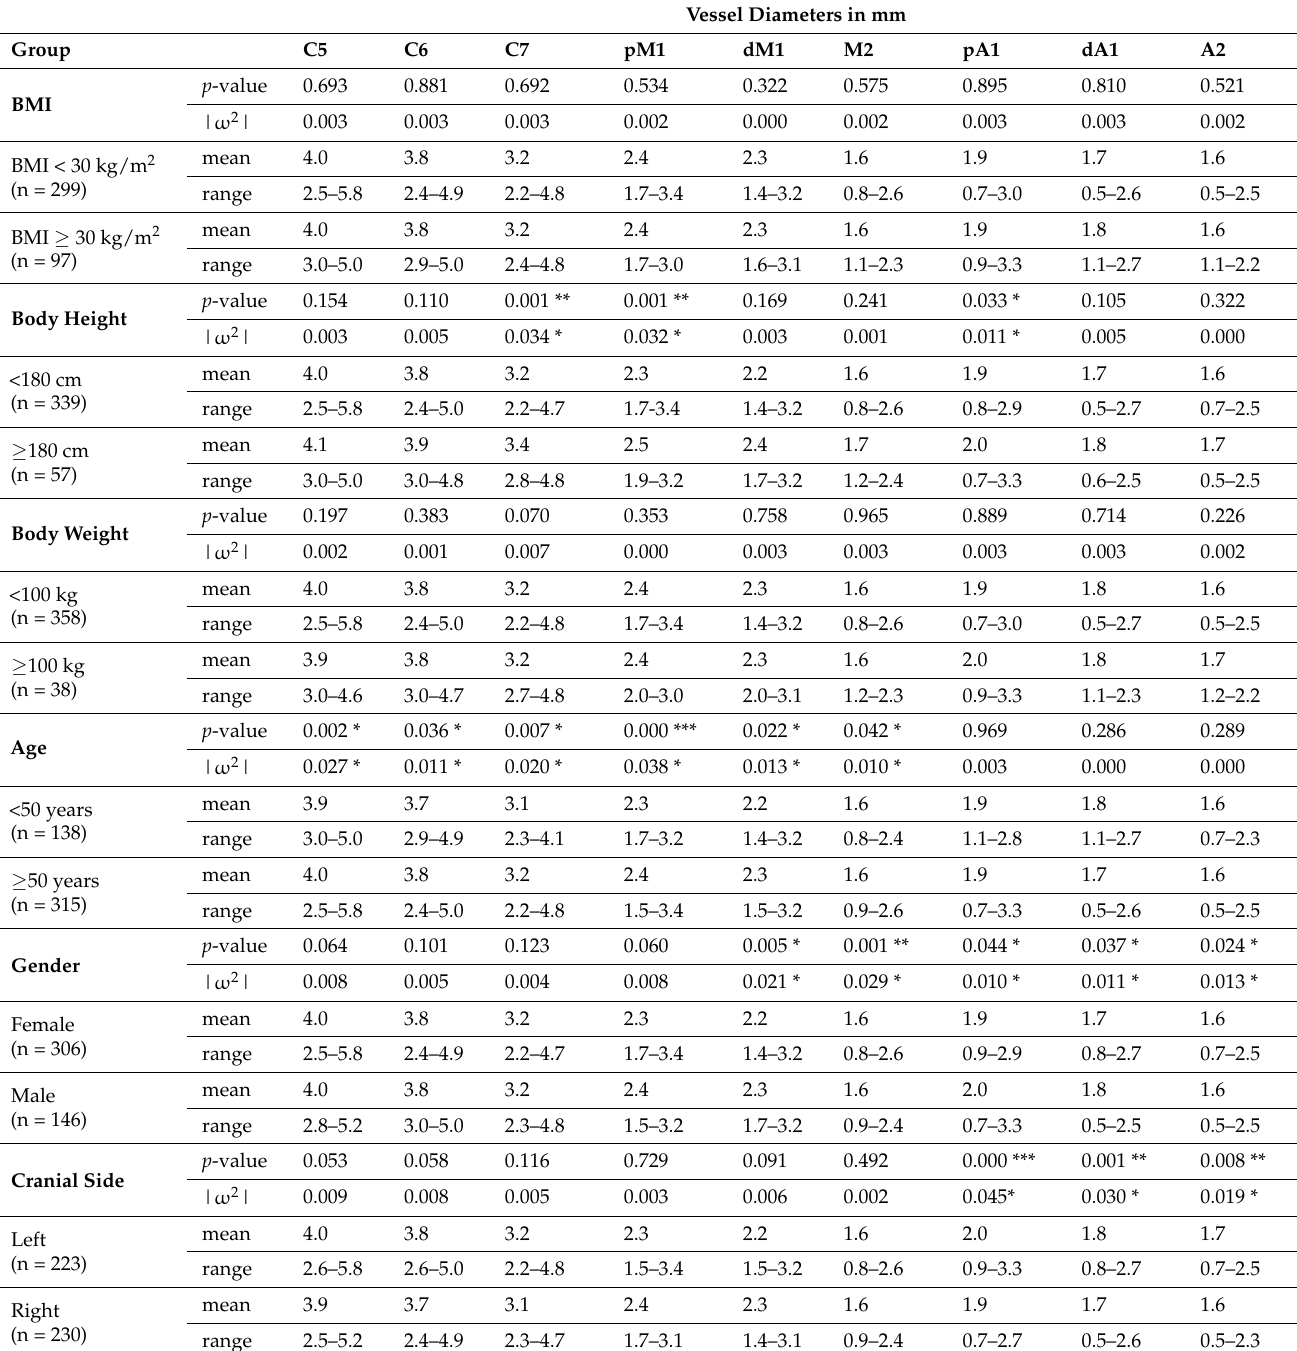
Table 2. Segment specific multivariate analysis of variance (MANOVA) and effect size for vessel diameters (in mm) according to physical